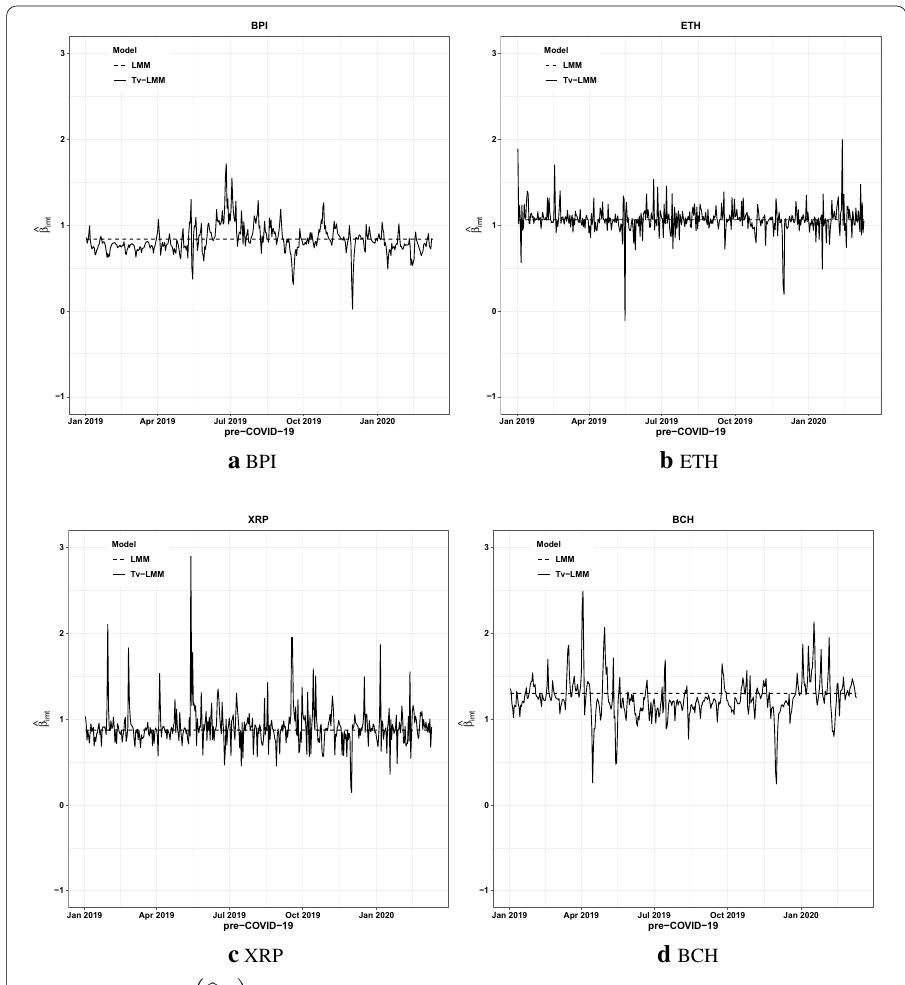
β imt plots of four cryptocurrencies in the pre-COVID-19 (cid:31) (cid:29) (cid:30)